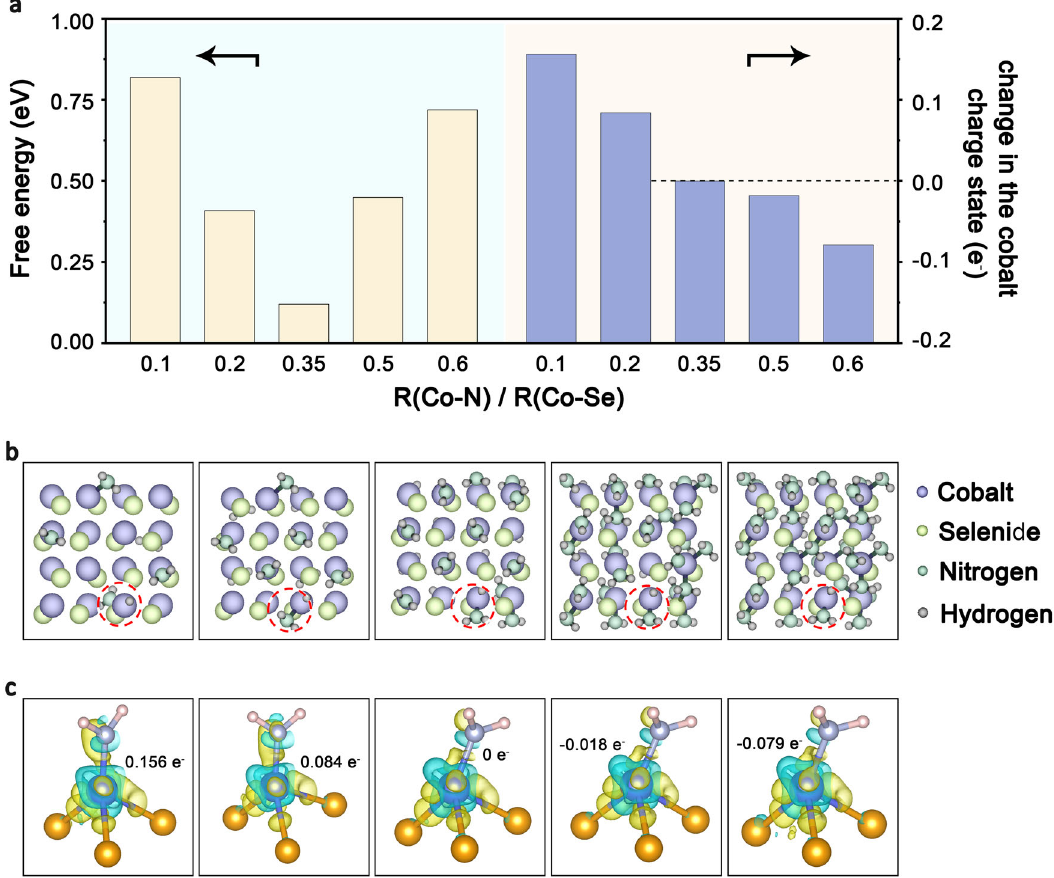
Fig. 5 | HER DFT calculations. a Calculated free energies and cobalt charge state changes of different R values, the ratio of number of Co-N bonds (R(Co-N)) to number of Co-Se bonds (R(Co-Se)). b , c Crystal structures ( b , the balls in purple, green,darkgreenandgrayrepresentCo,Se,NandH,respectively)anddifferential